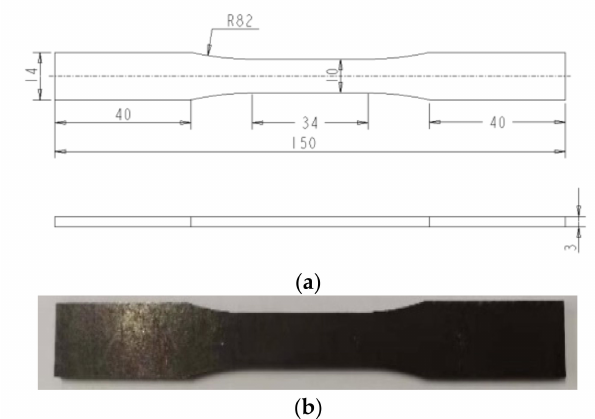
Figure 7. Q355 standard specimen: ( a ) specimen dimensions (unit: mm); ( b ) physical object.